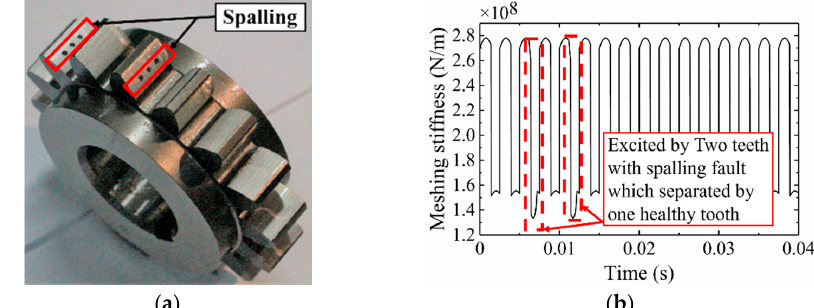
Figure 13. Status of tooth surface and mesh stiffness curves (two teeth with spalling fault, which are separated by one healthy tooth): ( a ) status of tooth surface and ( b ) mesh stiffness curves.